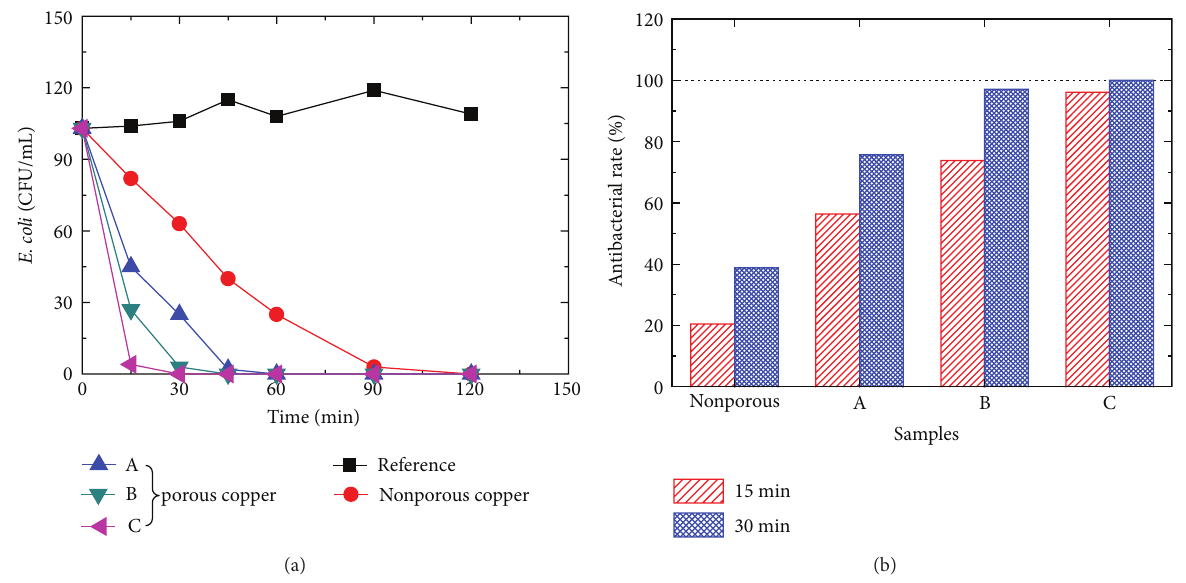
Figure 2: Time-course study of the (a) population and (b) antibacterial rates of nonporous and lotus-type porous copper against E. coli . The term “reference” in (a) refers to data obtained without involving copper